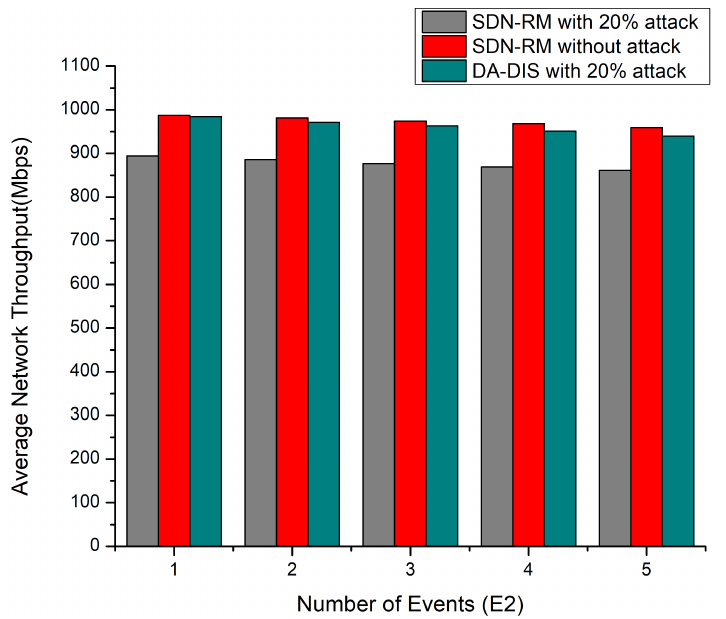
Figure 8. Throughput considering a different number of events (E2) and 20% malicious